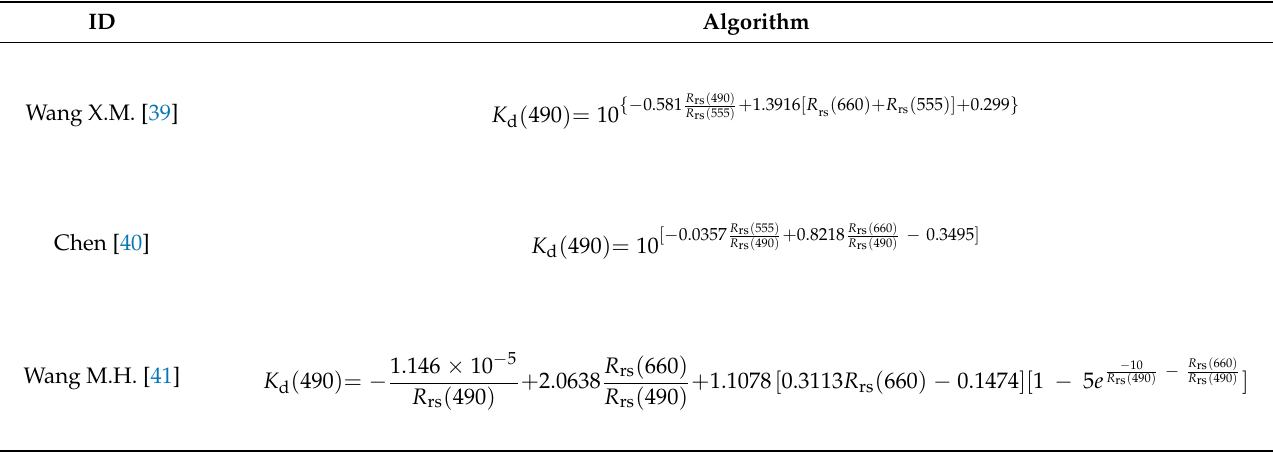
Table 1. Different algorithms of K d12 ( 490 ) adjusted for the central wavelengths of the GOCI.